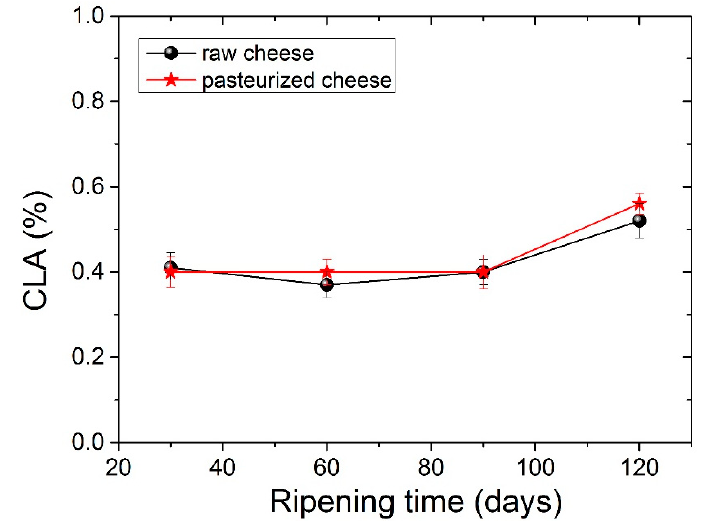
Figure 3. Conjugated Linoleic Acid-CLA values (%) for both types of cheese during ripening. Meanwhile, the amount of PUFA’s and n-6 FAs was significantly higher in milk ( p < 0.05), and it is noteworthy that the ratio between n-6/n-3 differed significant between the during cheesemaking. Table 6. Fatty acid composition (%) of milk, mature raw cheese and pasteurized cheese.